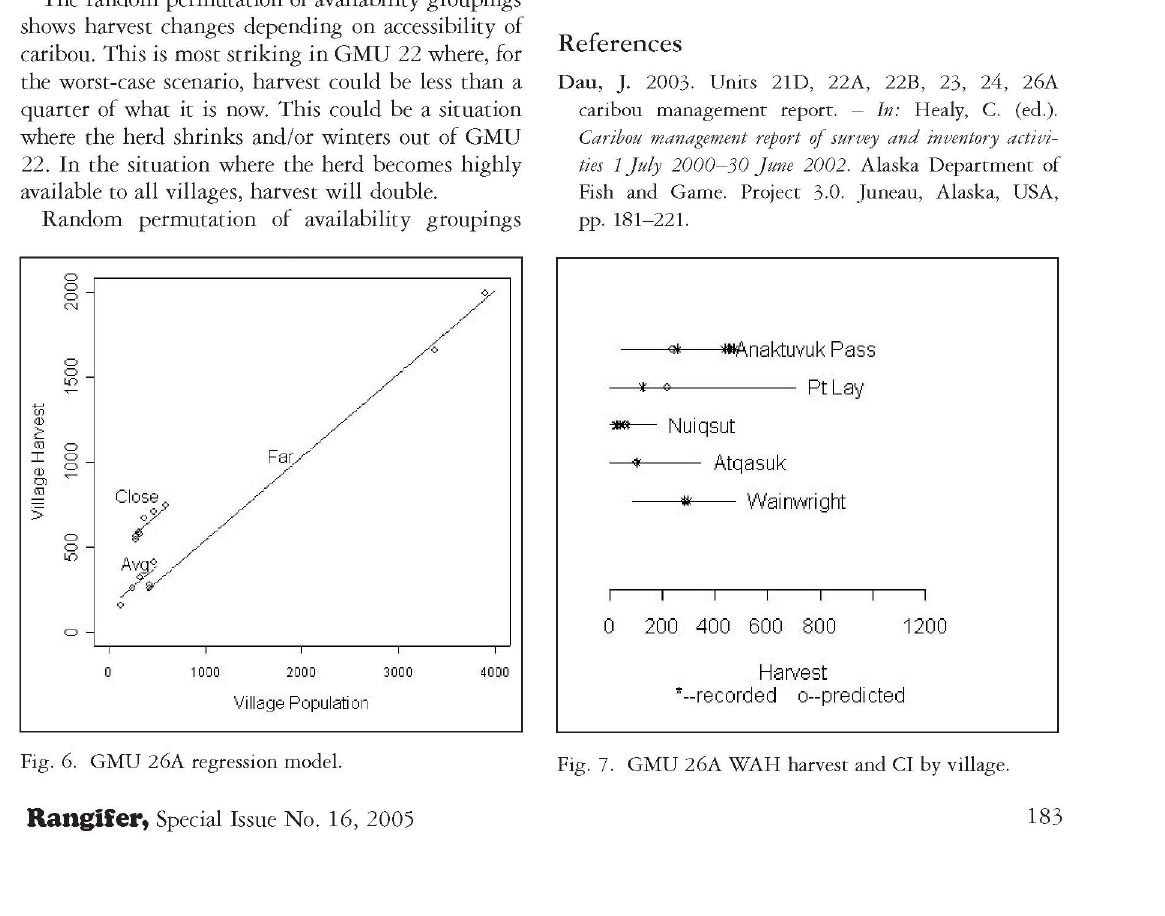
Fig. 6. GMU 26A regression model. Fig. 7. GMU 26A WAH harvest and CI by